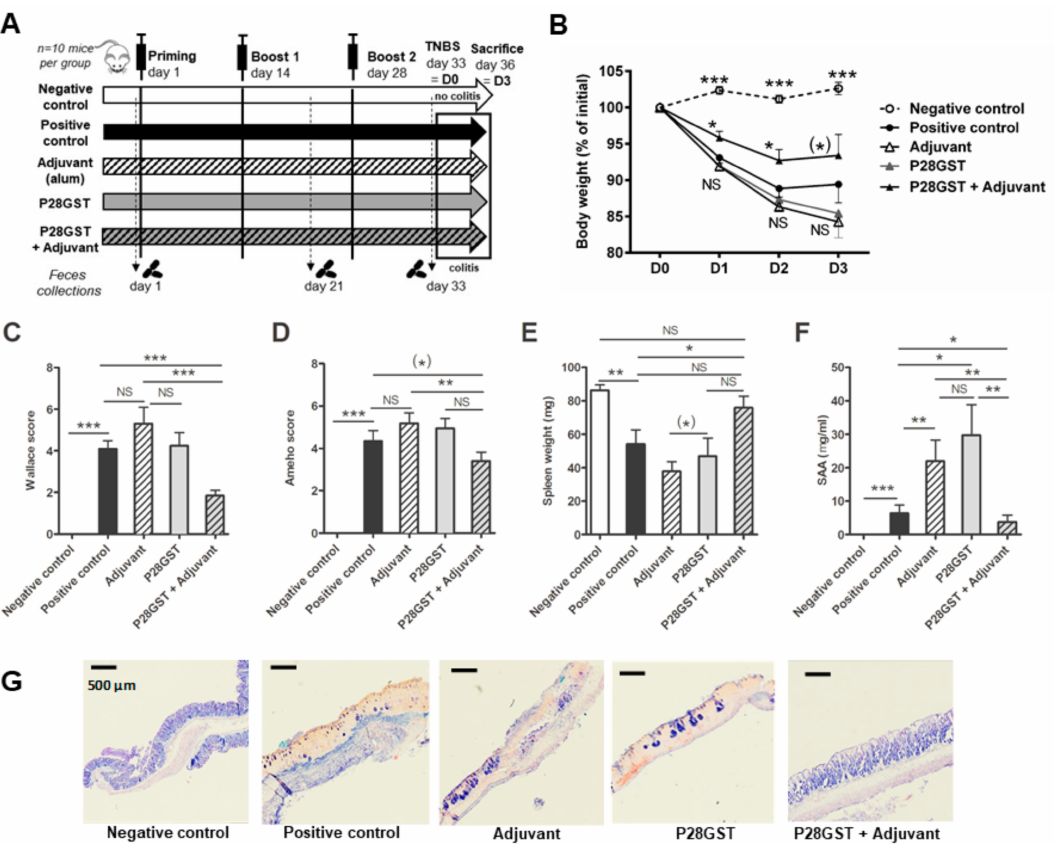
Figure 1. Prevention of 2, 4, 6-trinitrobenzene sulfonic acid (TNBS)-induced colitis in mice by 28 kDa glutathione S-transferase + Adjuvant (P28GST + Adjuvant) but not by adjuvant or P28GST alone. BALB / c mice received three subcutaneous injections of P28GST (5 µ g.kg − 1 ) without adjuvant, with adjuvant alone (aluminum hydroxide 0.2% solution), or P28GST combined with adjuvant, at 2 week intervals. Positive and negative colitis controls received saline. TNBS (100 mg.kg − 1 ) was induced in all groups except negative control at day 33 and mice were sacrificed at day 36 (3 days after). Fecal samples were collected before the immune priming (day 1), 1 week after the first boost (day 21), and after the second boost (day 33). ( A ) Experimental design showing the immunization procedure, the fecal sampling plan and the final colitis schedule in all groups of BALB / c mice. ( B ) Percentage of loss of initial weight (prior colitis, at day 33 = D0) expressed as the comparison of individual weights recorded at killing (day 36 = D3). ( C ) Macroscopic clinical scores of colons at day 36 according to the scoring system of Wallace. ( D ) Histological Ameho’s scoring of colons at day 36. ( E ) Weight of spleens removed at day 36 expressed in milligrams (mg). Atrophy of spleens observed in positive colitis control, Adjuvant- and P28GST-treated animals was restored in the (P28GST + Adjuvant)-treated group. ( F ) Enzyme-linked immunosorbent assay was performed to quantify individual murine serum amyloid A protein (SAA) in all groups of mice. SAA levels expressed as mg per ml of blood serum were significantly lower in the (P28GST + Adjuvant)-treated group than others. ( G ) Representative images from May–Grünwald and Giemsa staining of para ffi n-wax-embedded 6 µ m sections of the colon of mice in all groups. Bars = 500 µ m. Results are expressed as means ± SEM; n = 10 mice per group; * p < 0.05; ** p < 0.01; *** p < 0.001; ( * ) 0.05 < p < 0.1; NS, not significant is indicated when